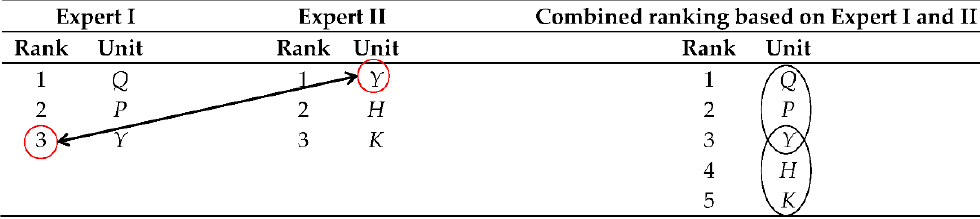
Figure 1. Input from Experts I and II combined into one ranking.